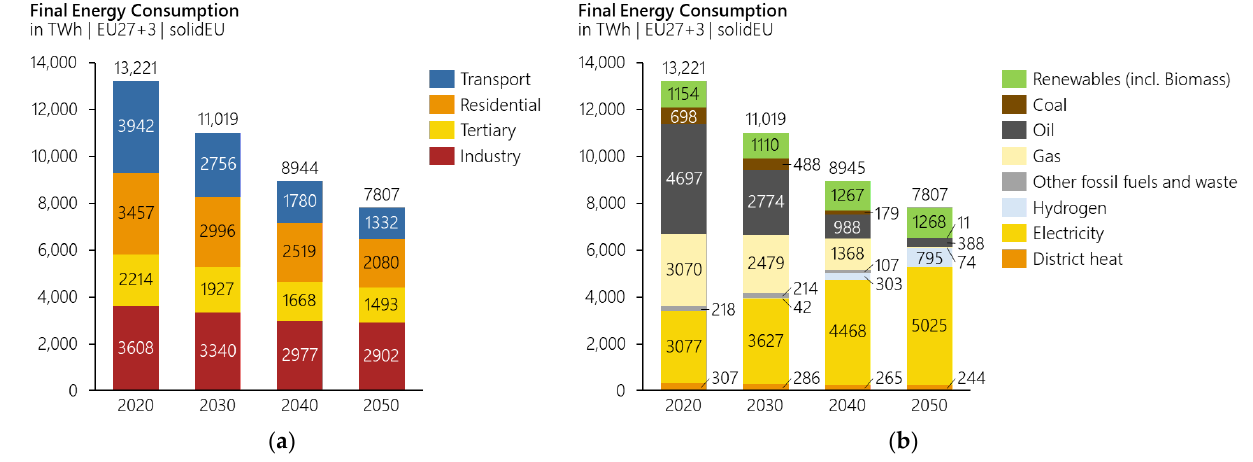
Figure 4. Development of FEC per sector ( a ) and energy carrier ( b ) in Europe [30].